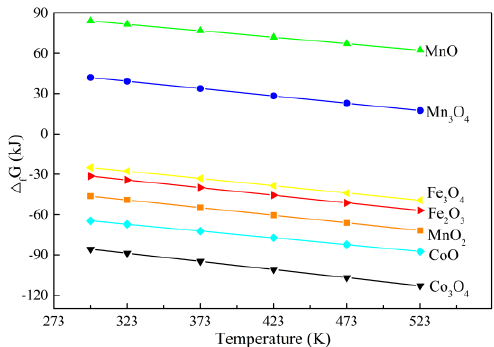
Figure 9. Temperature − Gibbs free energy curve for the reaction between M x O y and NH 3 .